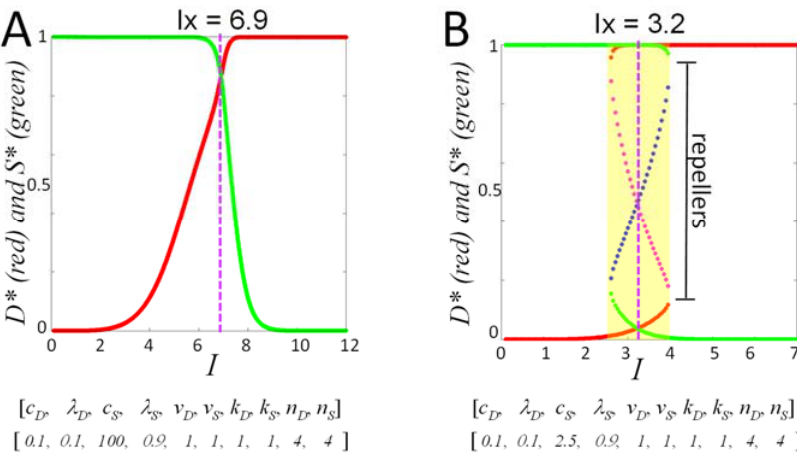
Figure 6. ( A ) Monostable and ( B ) bistable bifurcation diagrams from the autonomous dynamical theory of acute cell injury. Purple lines mark Ix . Input vectors are shown below the respective injury courses.